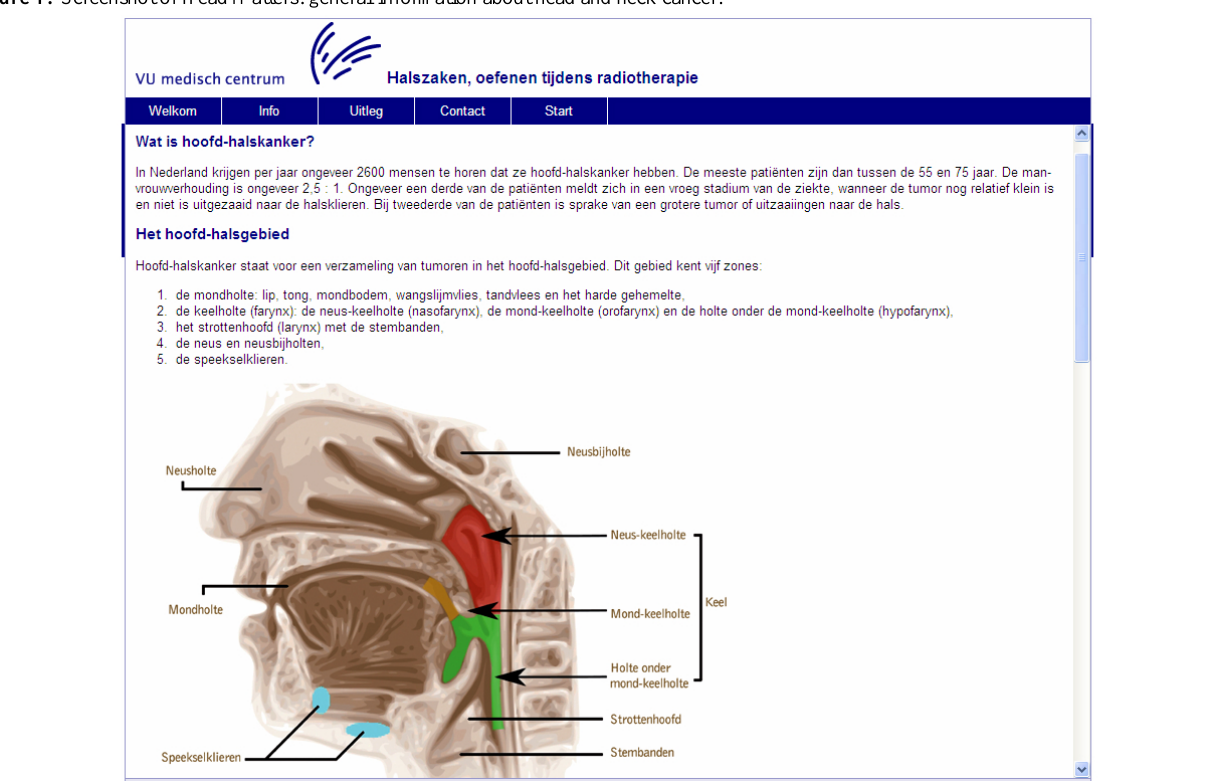
Figure 1. Screenshot of Head Matters: general information about head and neck